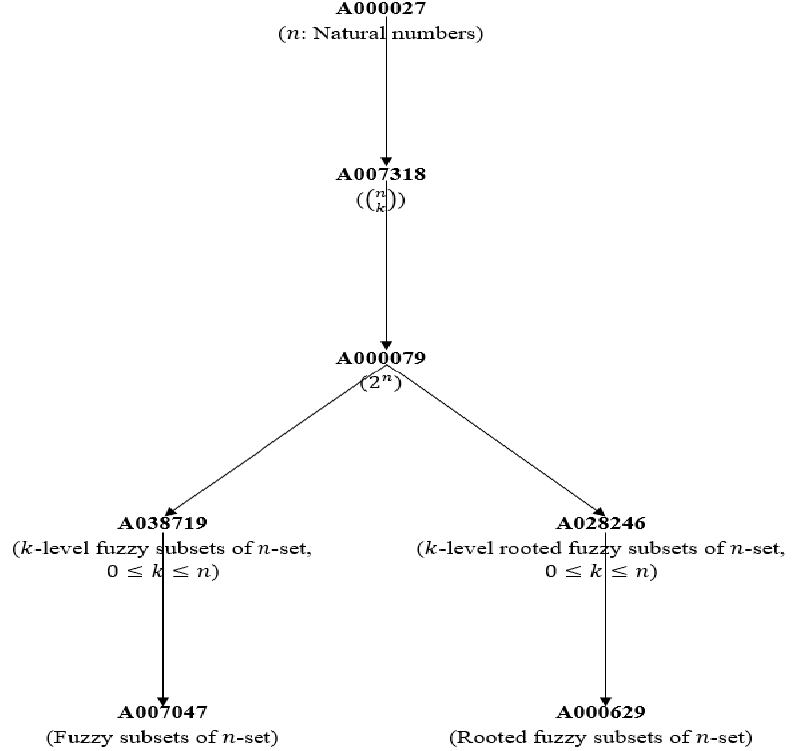
Figure 3. Connections between the sequences that are related to fuzzy subsets in the OEIS.